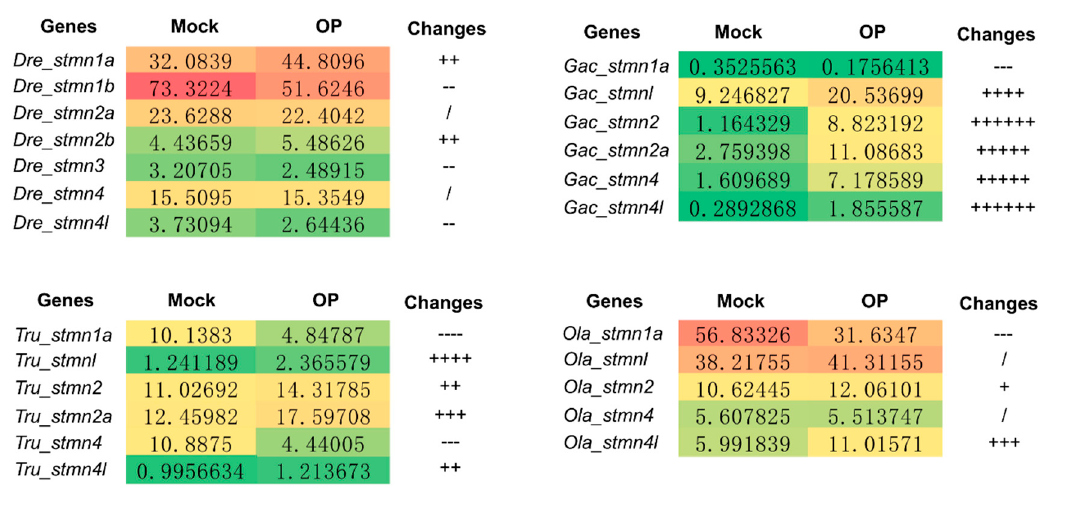
Figure 7. Expression profiles of the stathmin genes under dimethoate treatment in zebrafish, fugu, stickleback, and medaka.